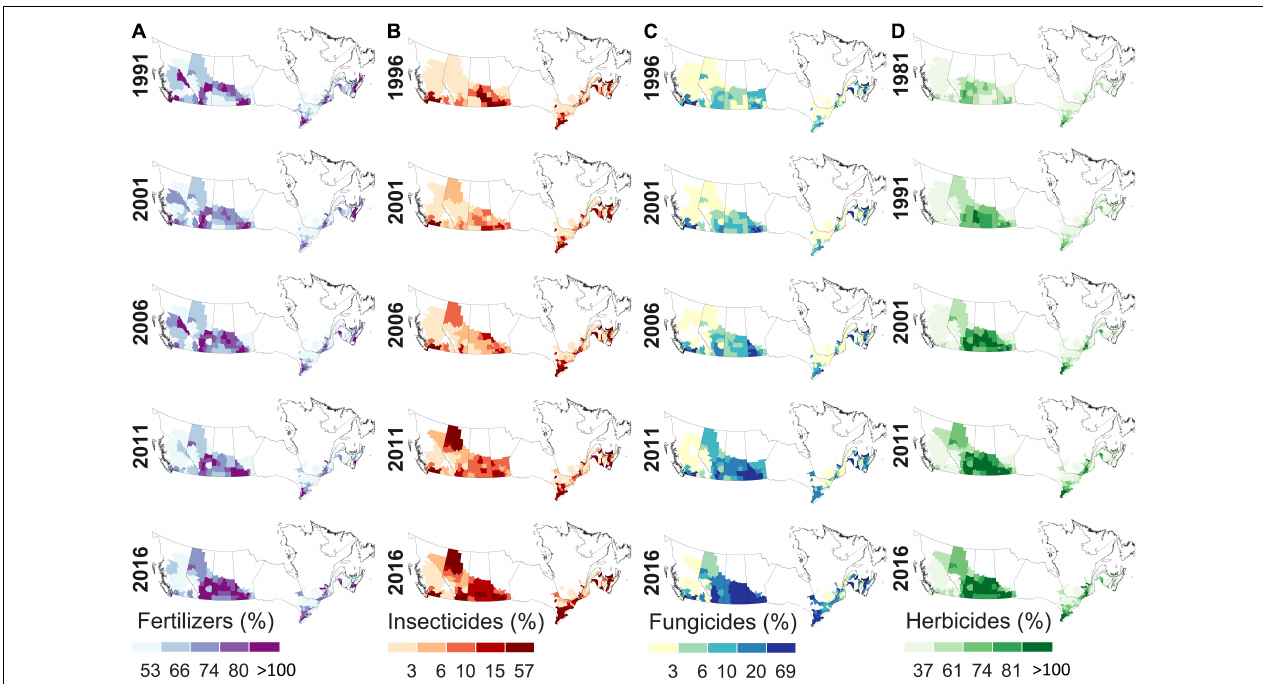
FIGURE 1 | Geographic distribution of agrochemicals calculated as percent of cropland treated with fertilizers (A) , insecticides (B) , fungicides (C) , and herbicides (D) for each census of agriculture year across Canada. Note that the date range from the Census of Agriculture varies by agrochemical group: fertilizers